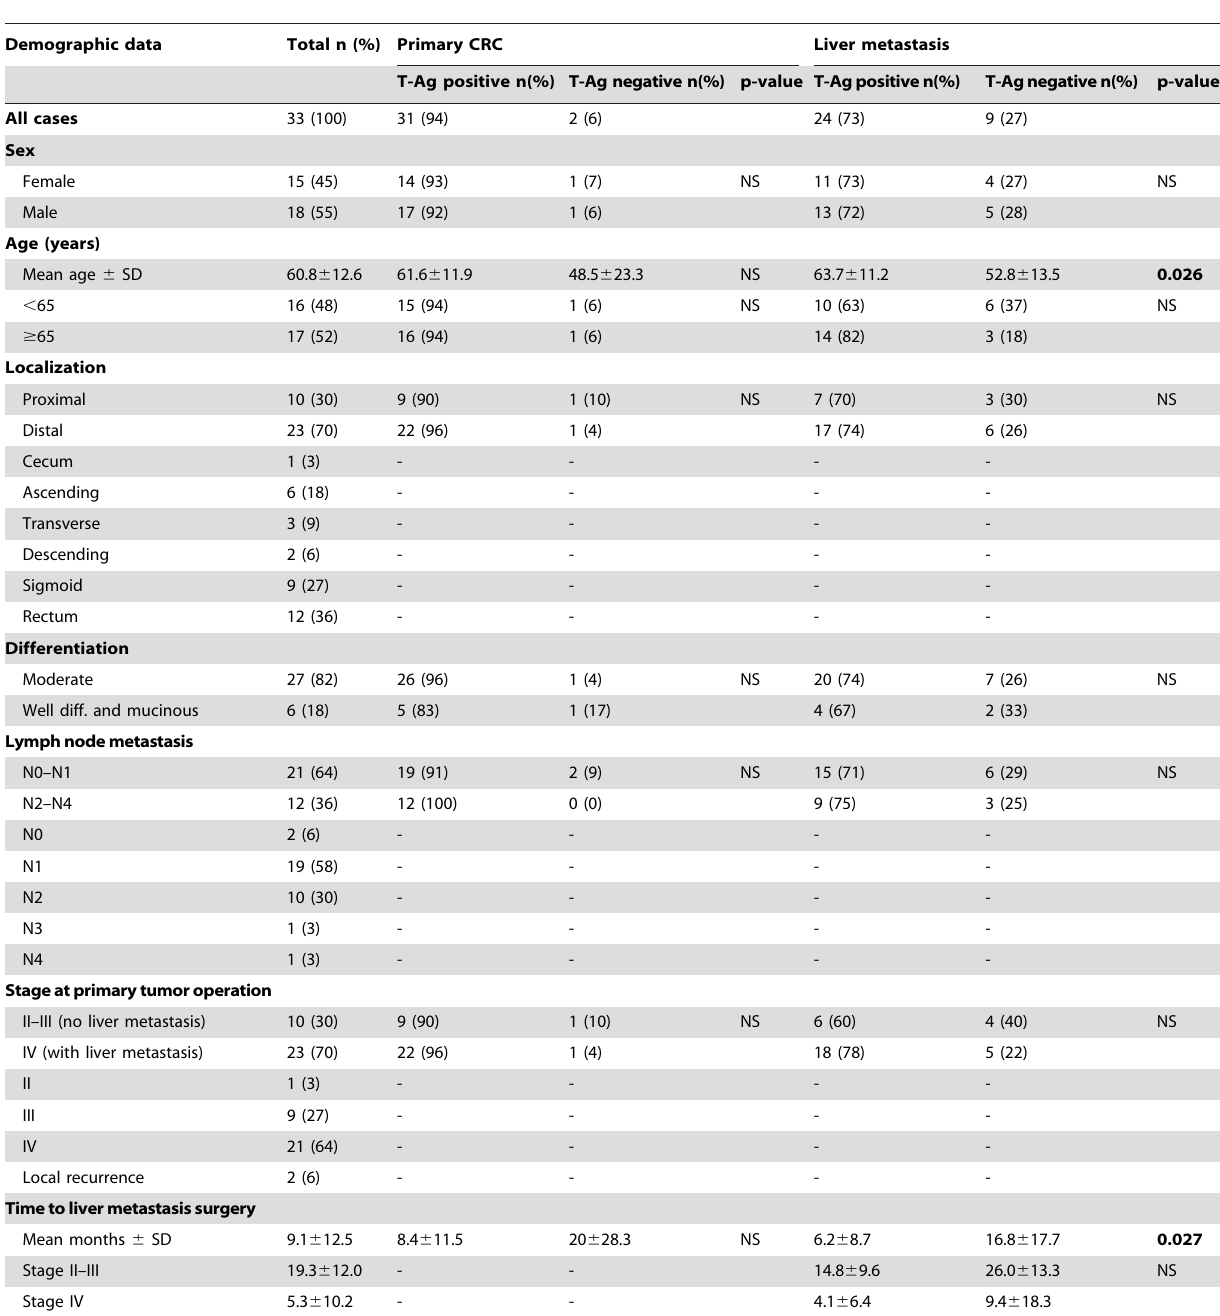
Table 1. JCV T-Ag expression in primary colorectal cancers and liver metastasis in correlation with clinico-pathological